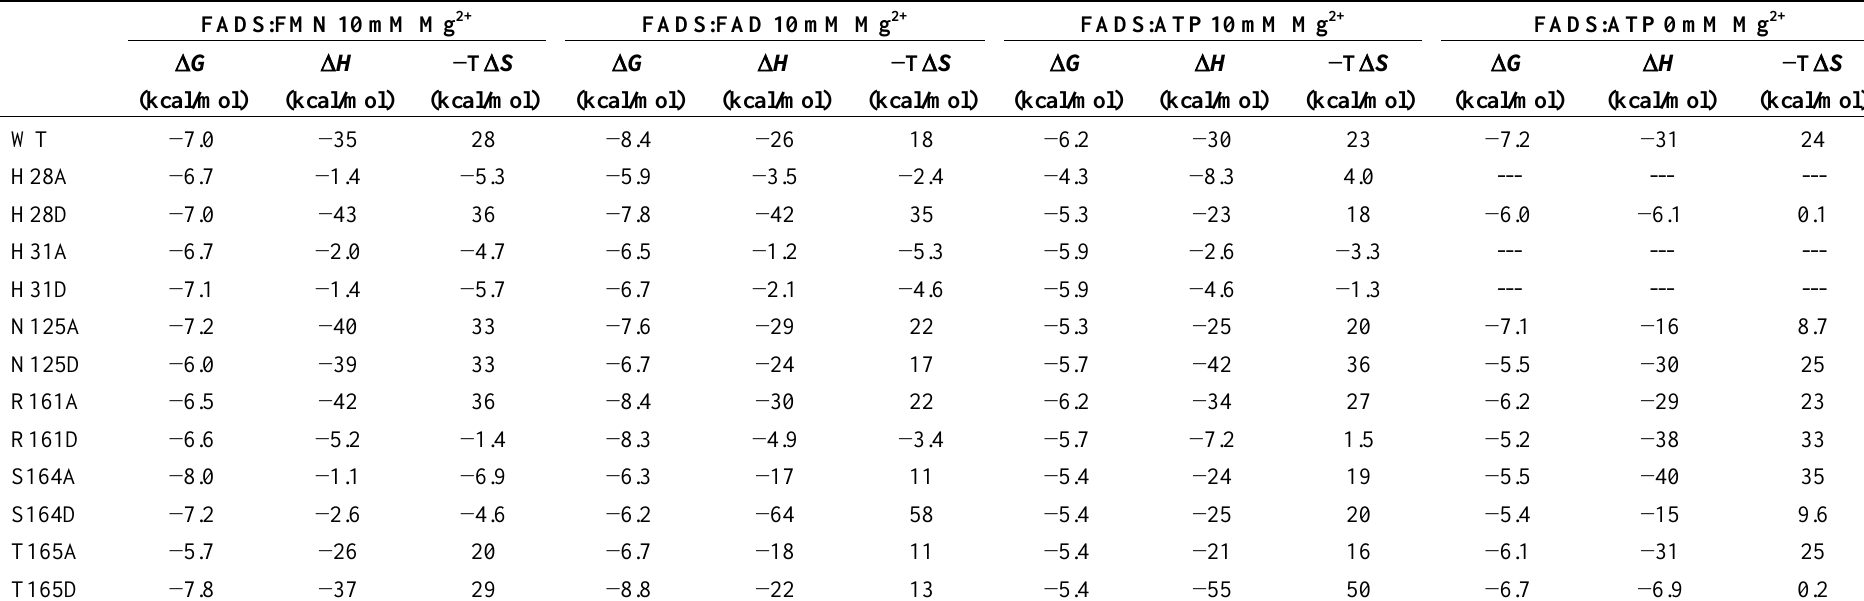
Table S3. Thermodynamic parameters for the interaction of Ca FADS WT and mutants with flavins determined by ITC. Data obtained at 25 °C in 20 mM PIPES, pH 7.0, at the indicated MgCl concentration. Errors in Δ G , Δ H and −TΔ S where ±0.3 kcal/mol, in general larger than 2 the standard deviation between replicates and the numerical error after fitting the